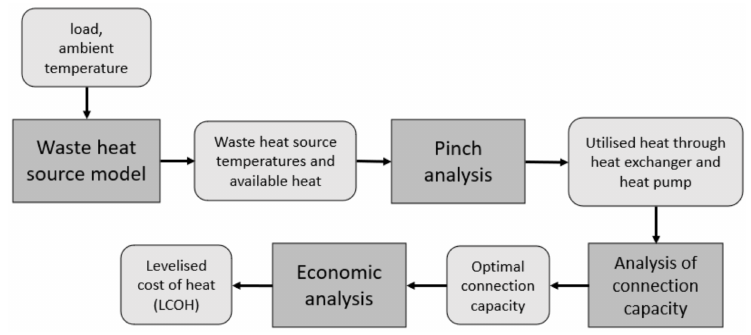
Figure 1. Method